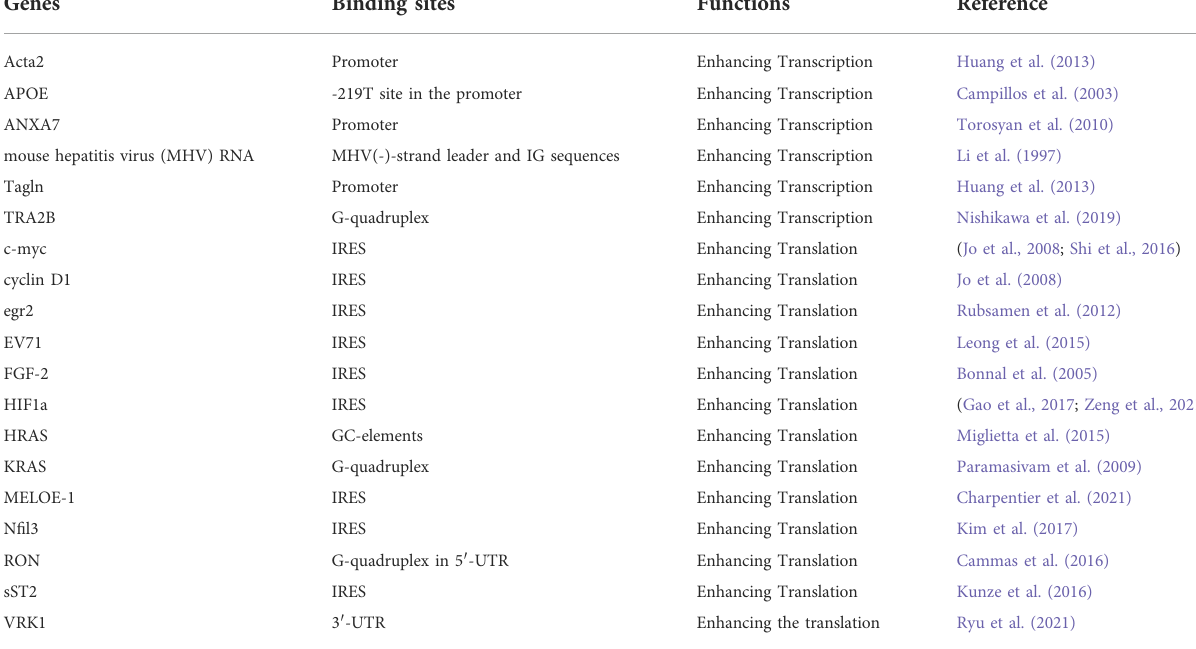
TABLE 2 The transcription and translation of genes enhanced by hnRNP